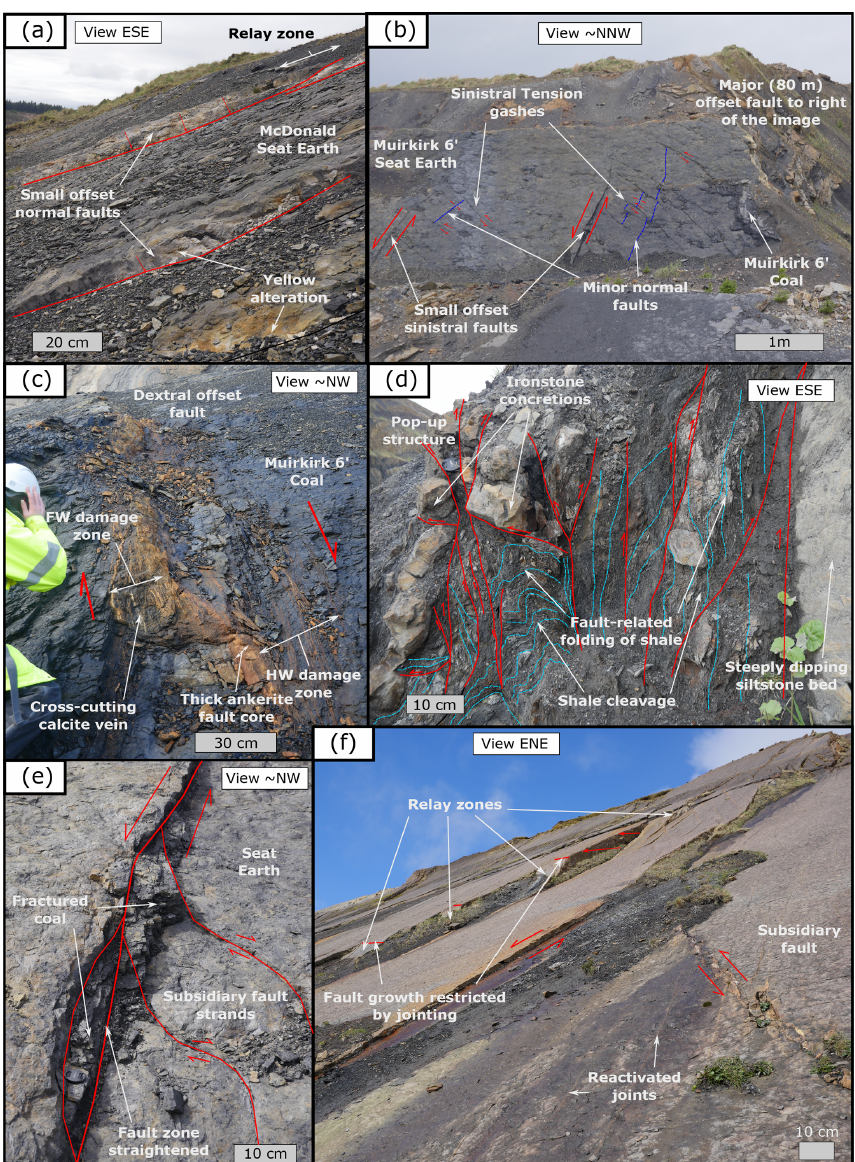
Figure 5. Characteristic observations of self-juxtaposed faults: (a) small stratigraphic offset (ca. 15cm) fault strands and relay structures and (b) tension gashes and small stratigraphic offset normal faults exposed within the McDonald Seat Earth in seat earth exposed to the far west of Spireslack SCM. (c) Symmetric damage zone and thick zone of ankerite mineralisation along a ca. 40cm stratigraphic separation dextral fault cutting the Muirkirk Six Foot Coal (FW stands for footwall, and HW stands for hanging wall). (d) Bed-parallel thrusts and folding developed within the shale that underlies the McDonald Limestone to the NE of the site. (e) The development of small pods of fractured McDonald Coal along a small stratigraphic offset sinistral fault exposed to the SW of the site. (f) The interaction between faults and joints along the southerly dipping bedding plane of the McDonald